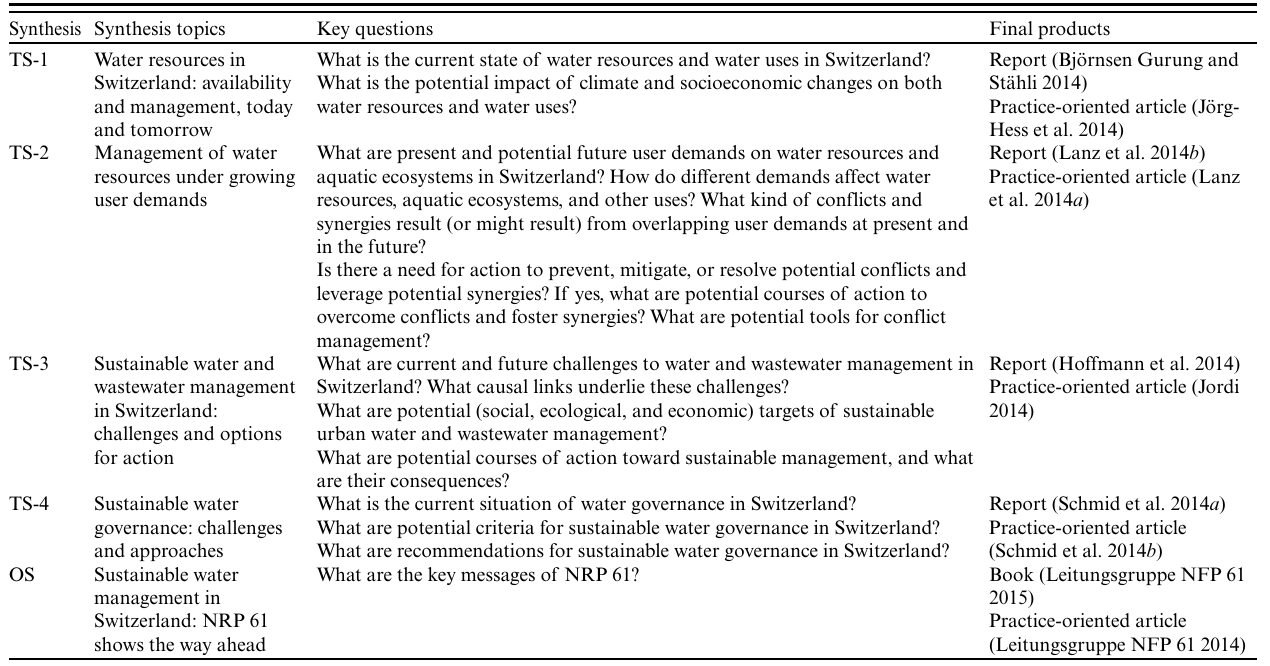
Table 2. Overview of synthesis topics, key questions, and final products of the four thematic syntheses (TSs) and one overall synthesis (OS) of the National Research Programme 61 on Sustainable Water Management (NRP